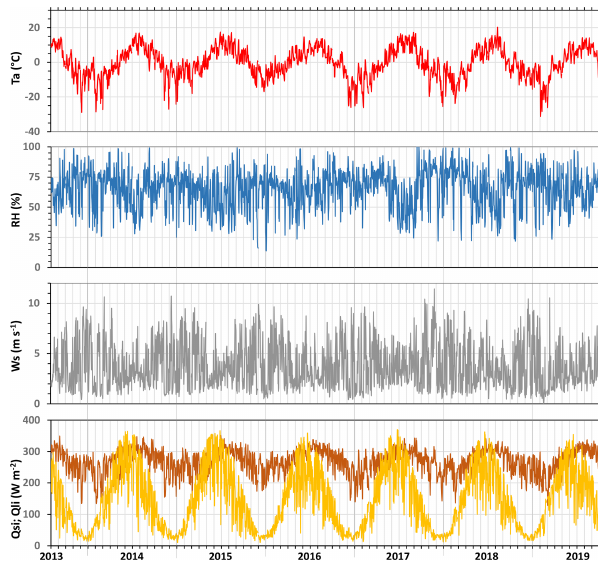
Figure 5. Peyto Main plots of 24h mean air temperature (Ta), rel- ative humidity (RH), wind speed (Ws), incoming shortwave radi- ation (Qsi) and incoming longwave radiation (Qli) – August 2013 to September 2019. Yellow and dark orange in the bottom panel, respectively, are incoming shortwave and longwave radiation.